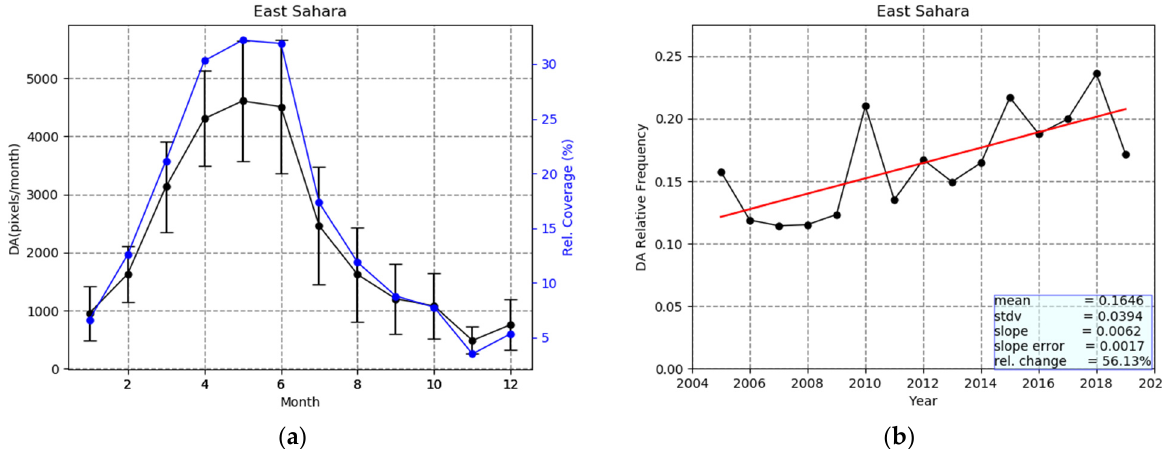
Figure 7. ( a ) Intra-annual variability of the 2005–2019 averages of the total absolute number of grid cells (1° × 1°) where dust aerosols (DA) were detected over East Sahara by the satellite algorithm (left axis) and the percent coverage of the region by dusty grid cells (right axis). The error bars represent the year-by-year variability by means of computed 2005–2019 standard deviations. ( b ) Inter-annual variability and linear trend of the relative frequency of dust aerosols (DA) over East